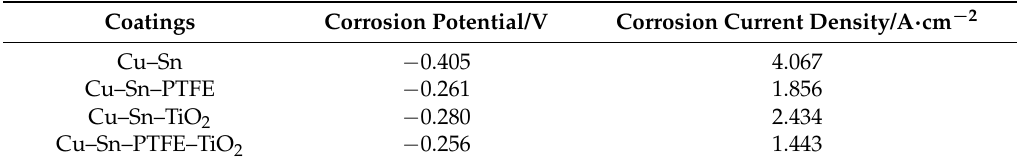
Figure 6. Potentiodynamic polarization curves of different coatings. Table 4. Potentiodynamic polarization parameters of coatings.